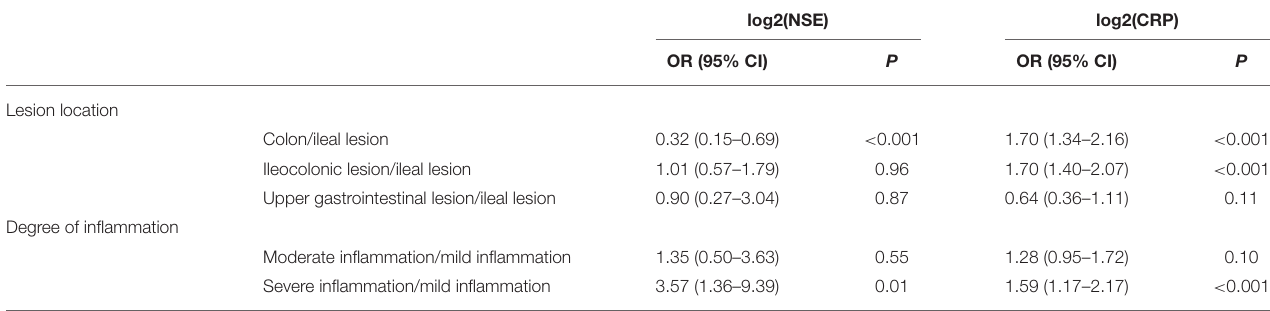
TABLE 2 | Association between different inflammation degrees, different lesion locations and NSE and CRP